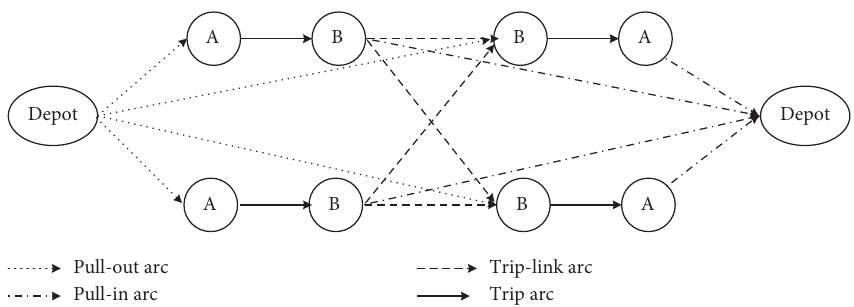
Figure 2: A network flow model for the VSP (Figure 2 is reproduced from [19]).